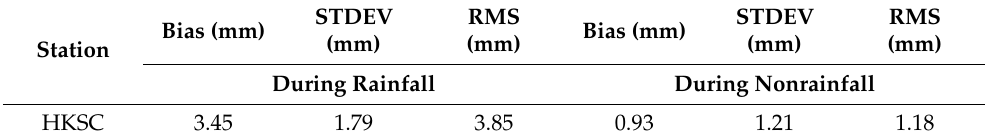
Table 7. Bias, STDEV, and RMS between PPP PWV and radiosonde station PWV.